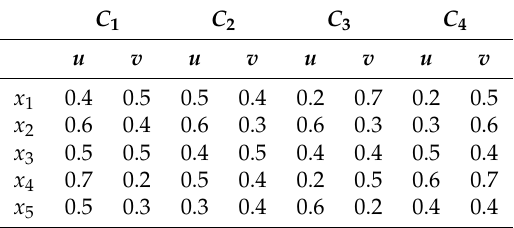
Table 1. q-rung orthopair fuzzy set (q-ROF) information decision matrix.